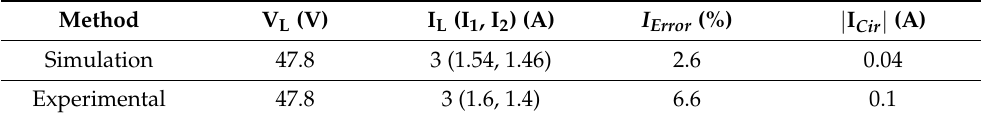
Table 14. Comparison of simulation and experimental results of proposed adaptive droop control for varying load and different cable